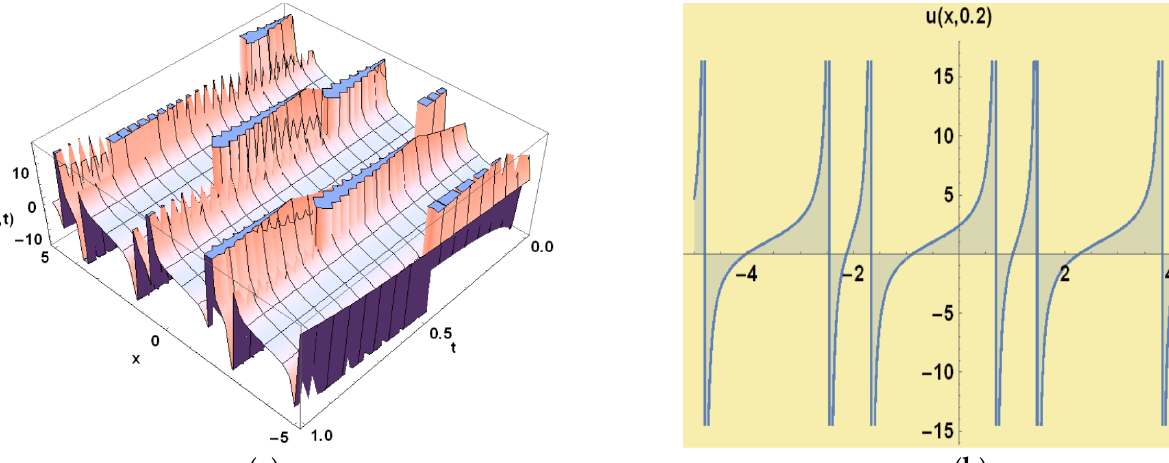
Figure 1. ( a , b ): Graphical analysis of Equation (19) for the values of the parameters A = 2, B = 1, E = 1, F = 1, H = 1, ψ = 1, δ = − 1, L = 1, α = 0.75, − 5 ≤ x ≤ 5, 0 ≤ t ≤ 1, for 3D and t = 0.2 for 2D plots.